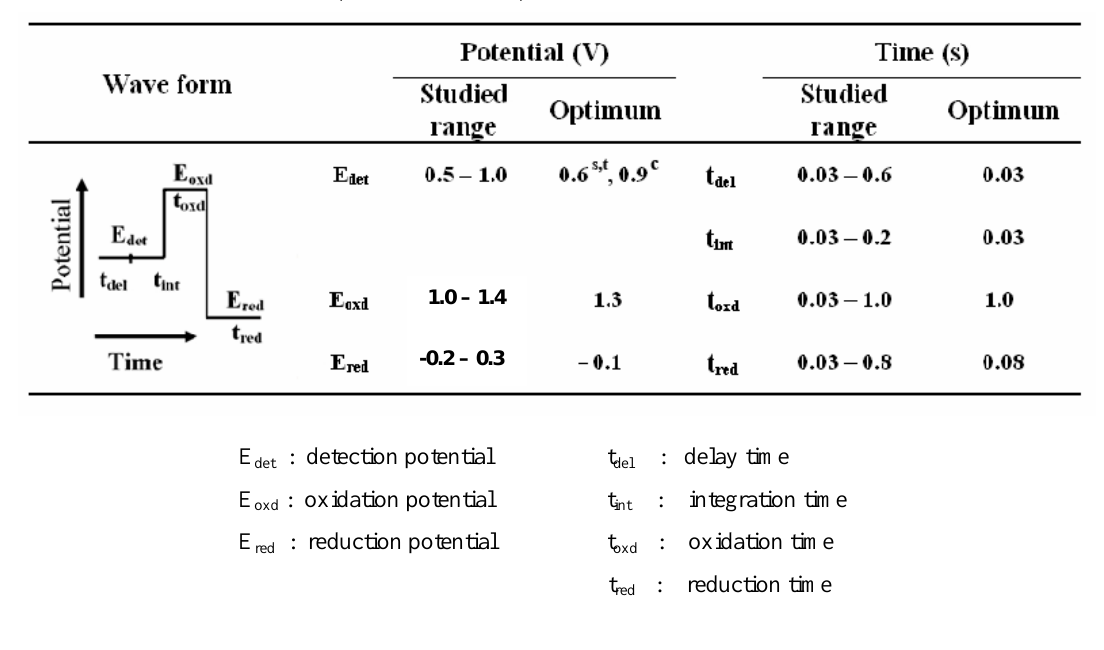
Table 1. Summary of the waveform for optimization PAD-BDD and the optimal